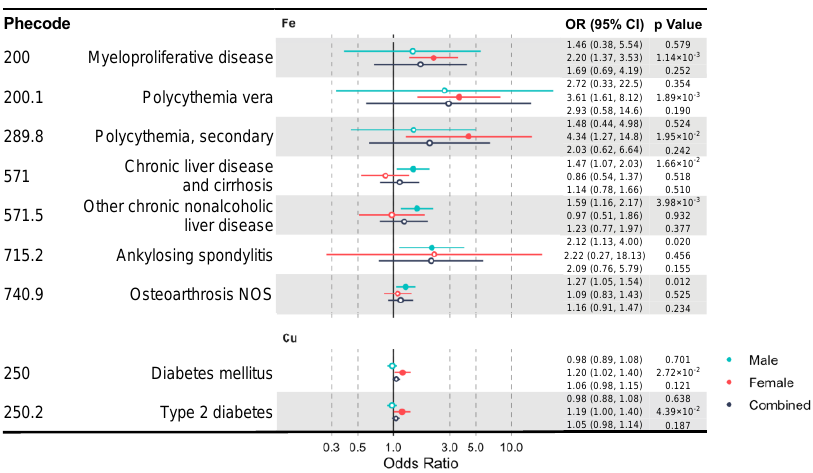
Figure 3. A forest plot showing significant mineral–outcome associations based on sex-stratified MR analysis. Results in the male, female, and combined analyses are shown. The causal estimates are from IVW MR and have no indications of pleiotropy. The odds ratios (ORs) with their 95% confidence intervals (CIs) are scaled to a 1-SD increase in blood mineral level. Complete MR results are provided in Table